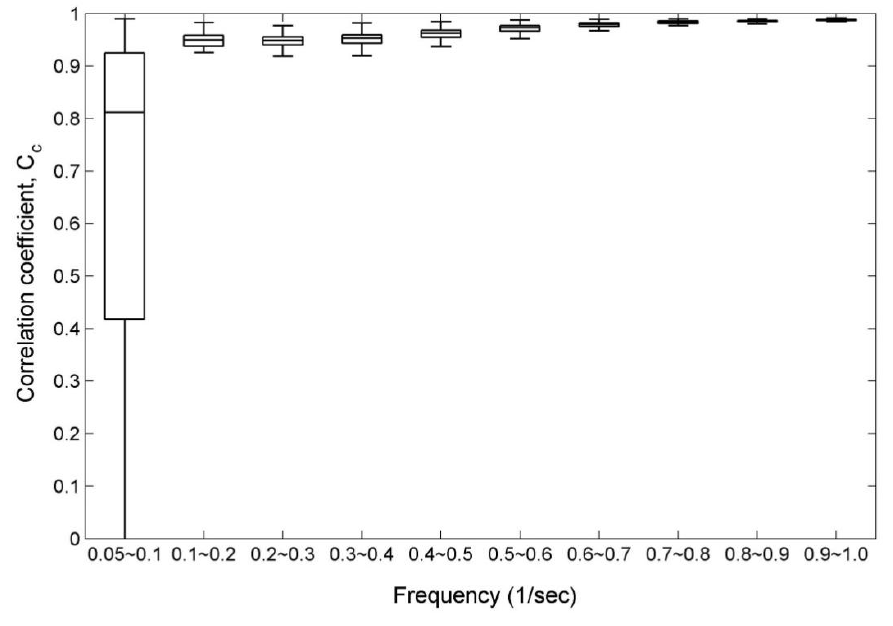
Figure 3. A box-whisker plot of correlation coefficients for paired wavelet spectra of 1,500 sea surface elevation records. One set of wavelet spectra was directly calculated from observational sea surface elevation records, and the other set was estimated from the synthetic acceleration data which were derived from observational records of sea surface elevations by means of double forward difference. The top and bottom of each box are the 25th and 75th percentiles of the samples, respectively. The line in the middle of each box is the sample median. The upper and lower whiskers present the highest and lowest results from the